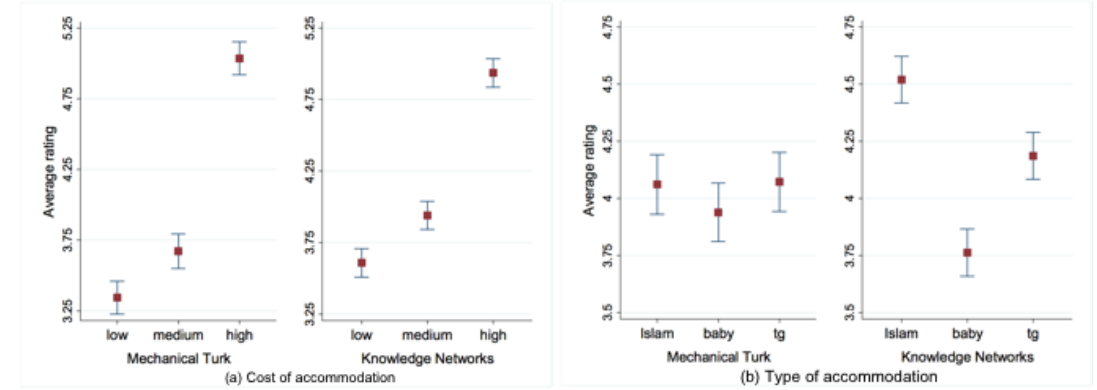
Figure 3: Differences in results of reasonable accommodation experiment between MT and